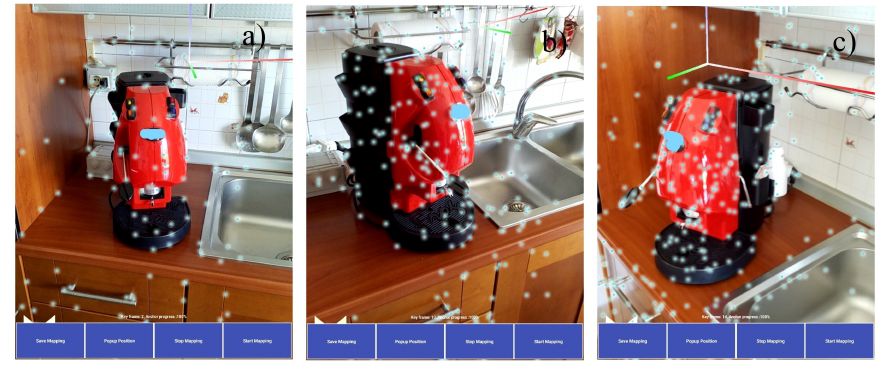
Figure 15. Features extraction from different points of view for robust object